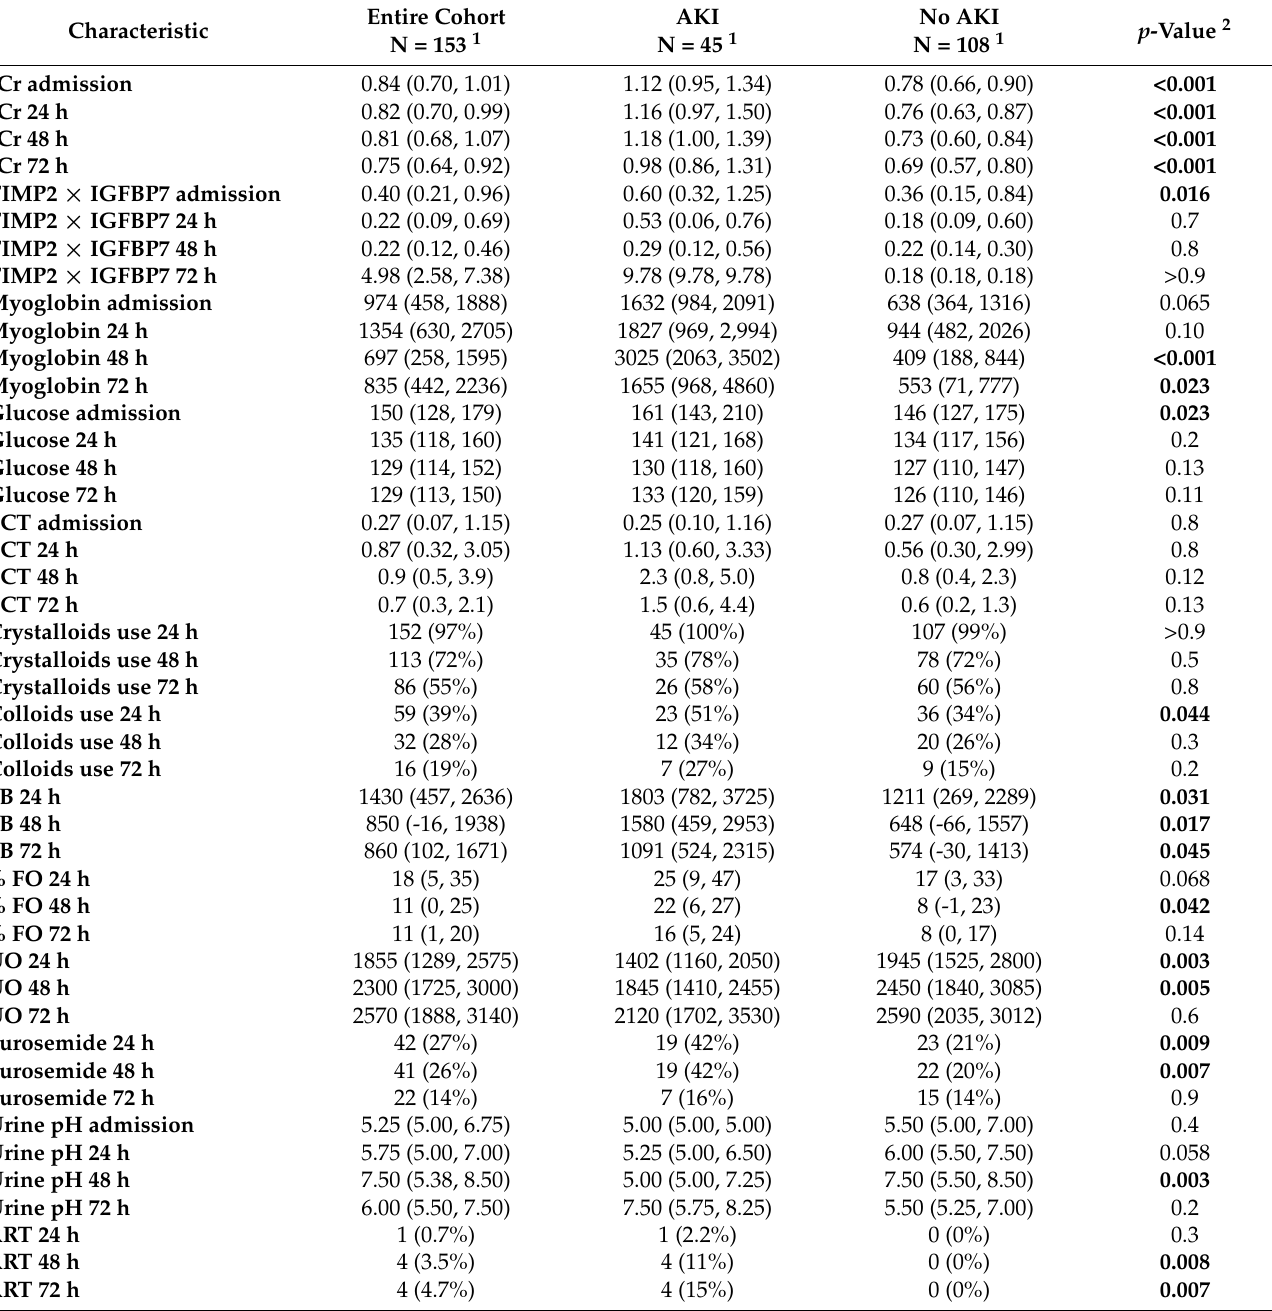
Table 2. Fluid balance, urinary output, biomarkers, need for RRT, and inflammatory markers in the entire cohort and according to